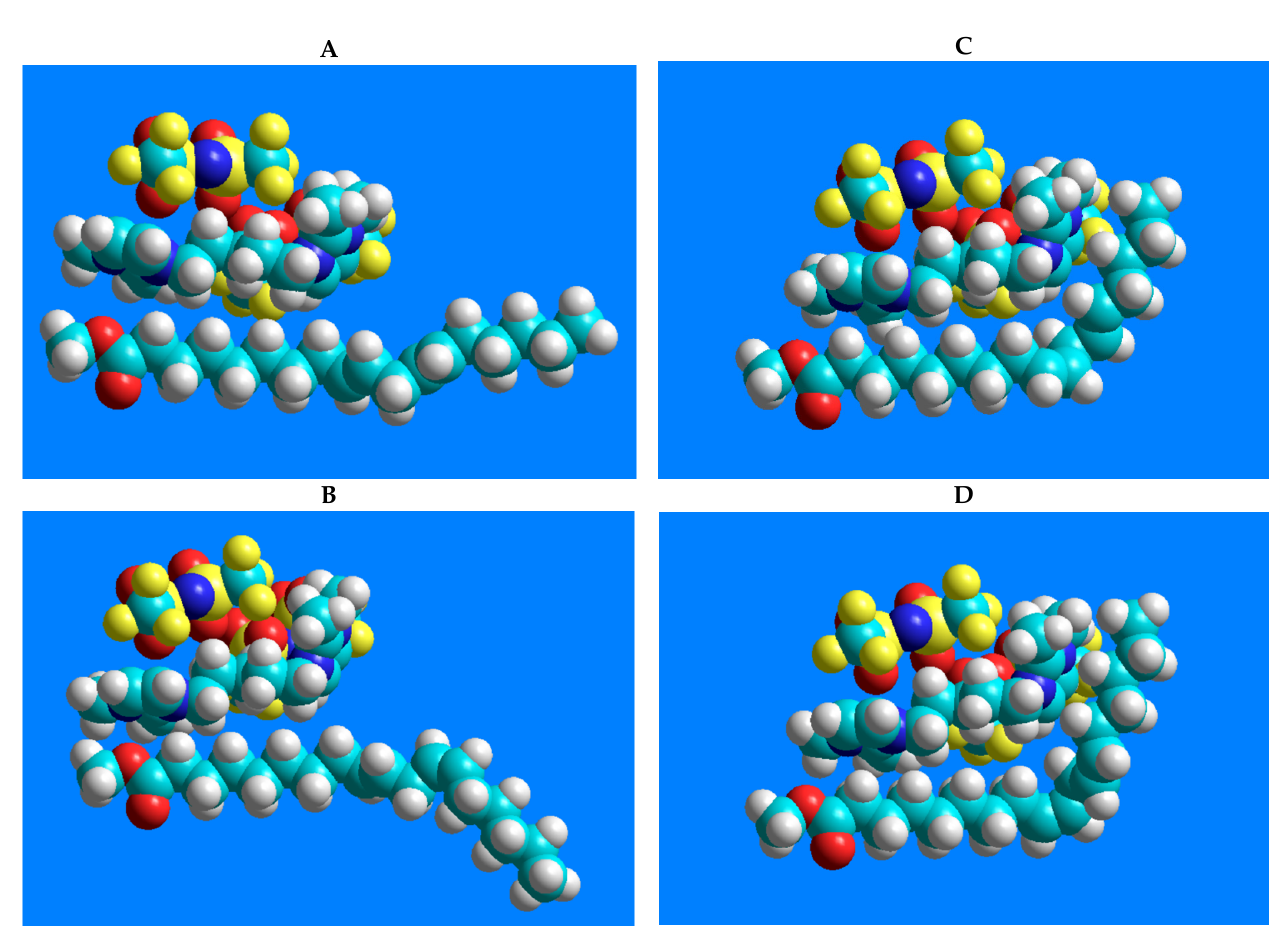
Figure 4. Models of the possible positioning of the 1,5-di(2,3-dimethylimidazolium)pentane bis(trifluoromethylsulfonyl)imide ionic liquid and the geometric isomers of linoleic acid methyl ester. The structure-related polarity of the components from low polarity to higher polarity is as follows: ( A ) C18:2n-6tt, ( B ) C18:2n-6tc, ( C ) C18:2n-6ct, ( D ) C18:2n-6cc.